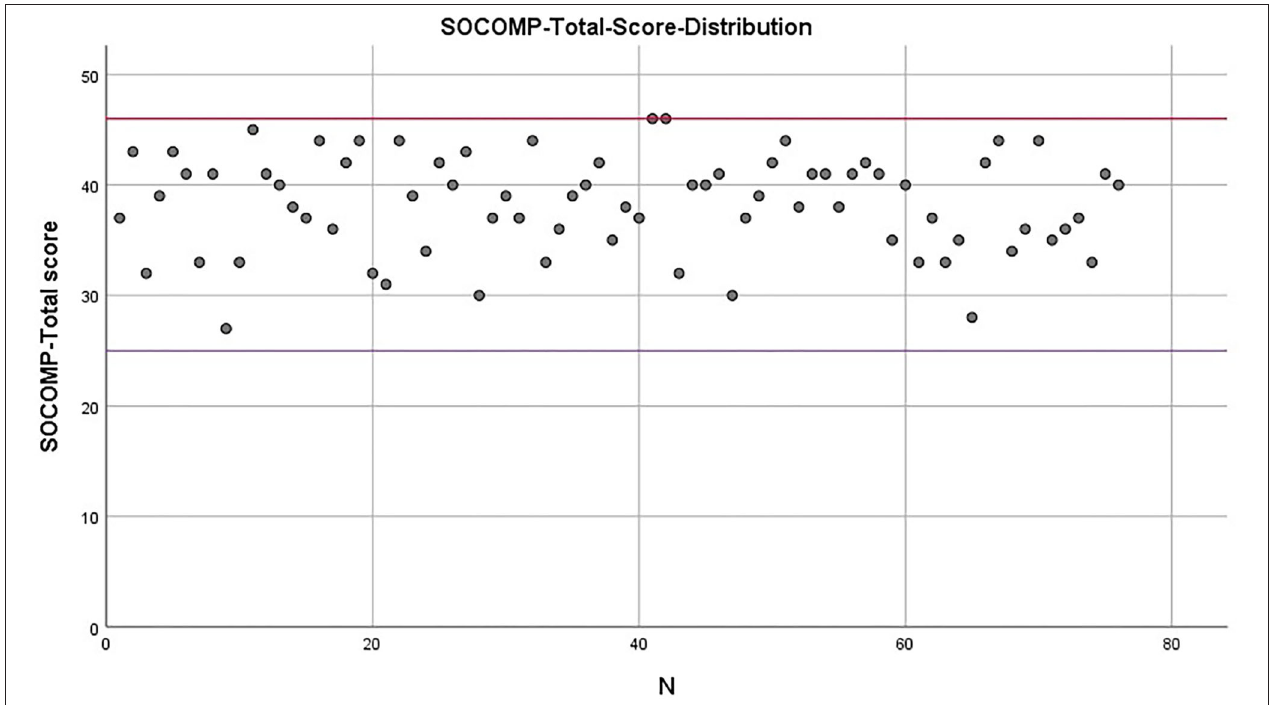
FIGURE 2 | SOCOMP total score distribution with provisional cut-offs equal to 25 (purple line) and lower, standing for low social skills, and 46 (red line) and higher, for high social skills ( n = 76).